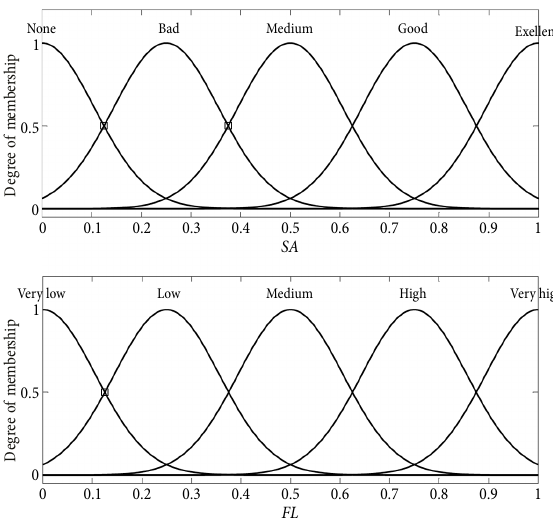
Fig. 8. The membership functions for the SA and the FL